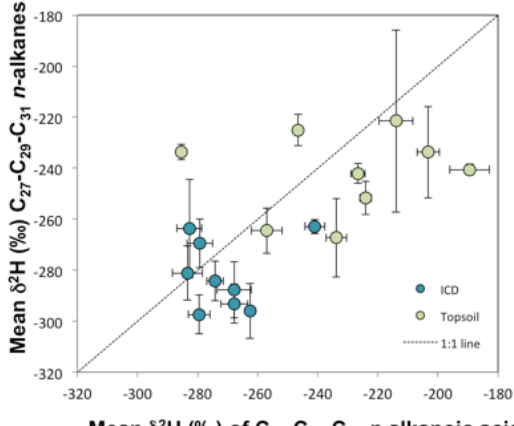
Figure 4. Concentration-weighted mean δ 2 H values of C 27 –C 29 – C 31 n -alkanes plotted against concentration-weighted mean δ 2 H values of C 24 –C 26 –C 28 n -alkanoic acids to illustrate the fraction- ation differences between these two leaf wax markers. Dashed line indicates an identical fractionation.